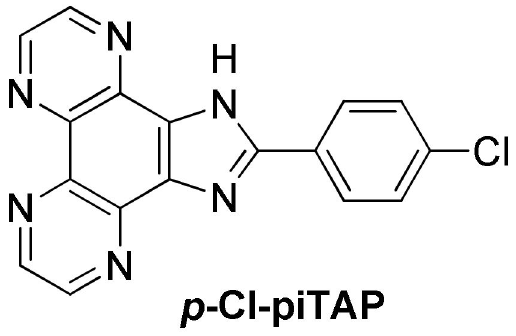
Figure 21. Structure of the imidazo-TAP ligand studied by Elias et al.